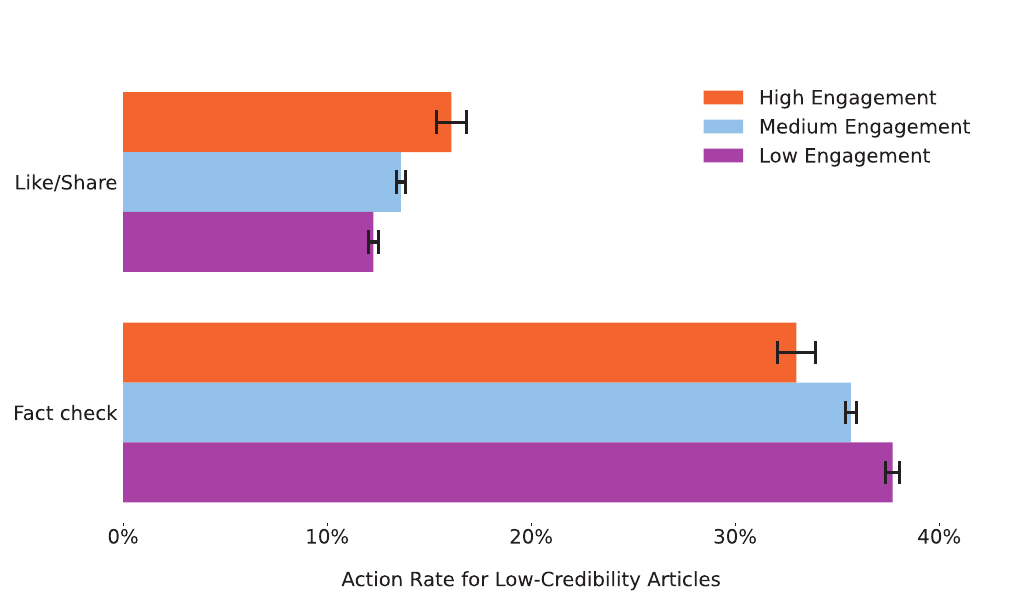
Figure 2: Mean rates of liking/sharing and fact checking low-credibility ar(cid:415)cles for low, medium, and high social engagement levels. Error bars indicate the standard